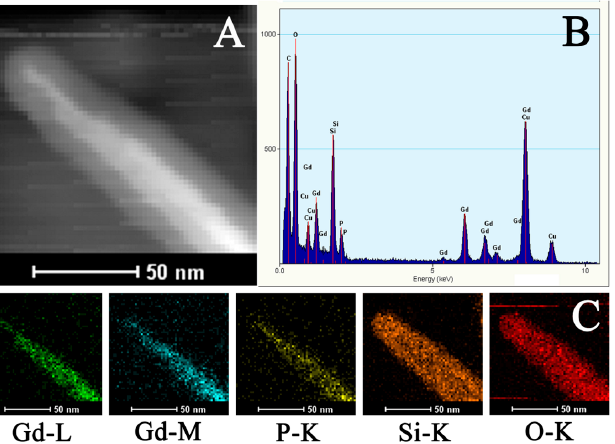
Figure 3. TEM ( A ), EDS ( B ) and element distribution ( C ) images of GdPO 4 · H 2 O@SiO 2 with the ratio of m GdPO4·H2O :V TEOS (mg/mL) = 1:1.